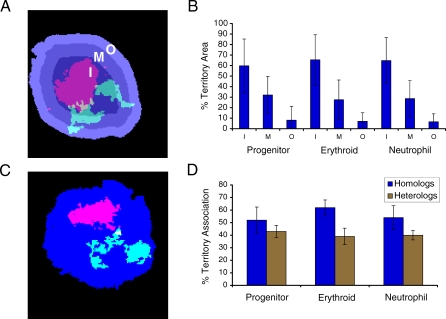
CTs Are Enriched in the Nuclear Center with a Propensity for Homolog Association(A) Erythroid nucleus counterstained with DAPI and CTs 11 (red) and 2 (green) detected by FISH. The nuclear area is divided into three shells—I, M, and O—of equal area as described in Figure 3.(B) Bar graph of resulting means for the analysis of CT positioning for Chromosomes 2, 3, 4, 5, 6, 7, 11, 12, 14, 17, and 19 in the three lineages (for individual chromosome data, see Figure S4).(C) Erythroid nucleus counterstained with DAPI and CTs 7 (red) and 19 (green) detected by FISH. Homologous and heterologous associations were measured by intensity thresholding to remove background and to create a mask of the CT area. Associations were measured only for merged masks (indicated in yellow for the 7 and 19 association).(D) Bar graph of results for the analysis of CT association for chromosomes indicated above (homologous association) and pair-wise analysis of chromosome pairs 2–11, 3–6, 4–5, 7–19, 12–14, 17–19 (heterologous association) as a mean for all analyzed chromosome relationships in the three lineages (for individual chromosome data, see Figure S6A and S6B). At least 30 nuclei were analyzed from each lineage; lines indicate SD.